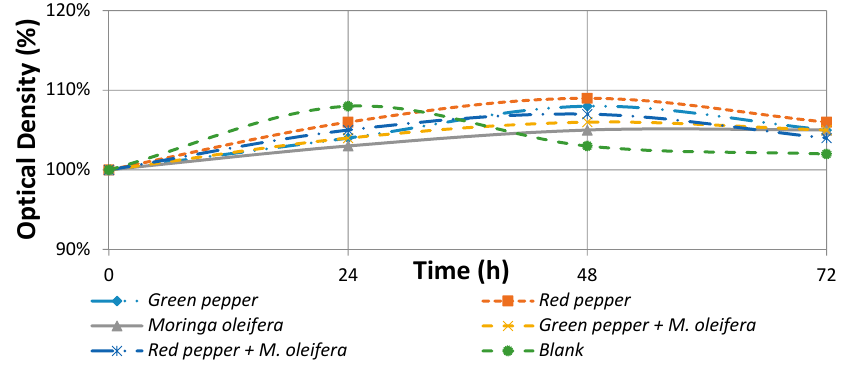
Figure 1. Changes in turbidity (optical density) of microemulsions (MEs) at 4 °C during 0, 24, 48, and 72 h.